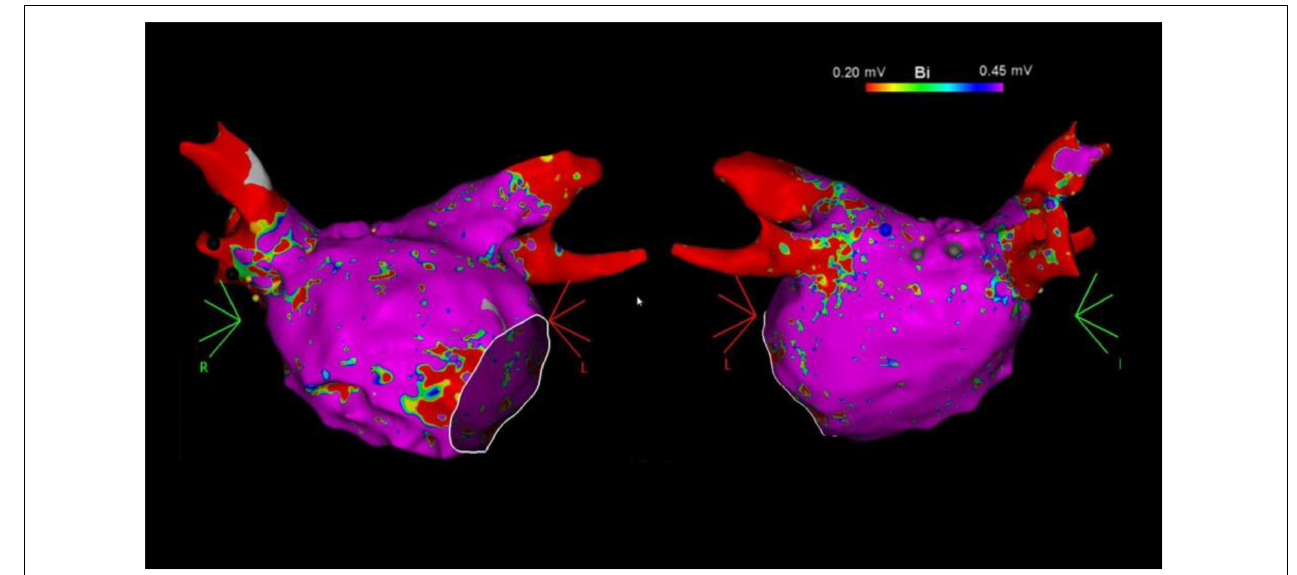
FIGURE 1 | Example of left atrial bipolar voltage maps (0.20–0.45 mV) in the anterior (left) and posterior (right) views recorded with the multielectrode catheter prior to catheter